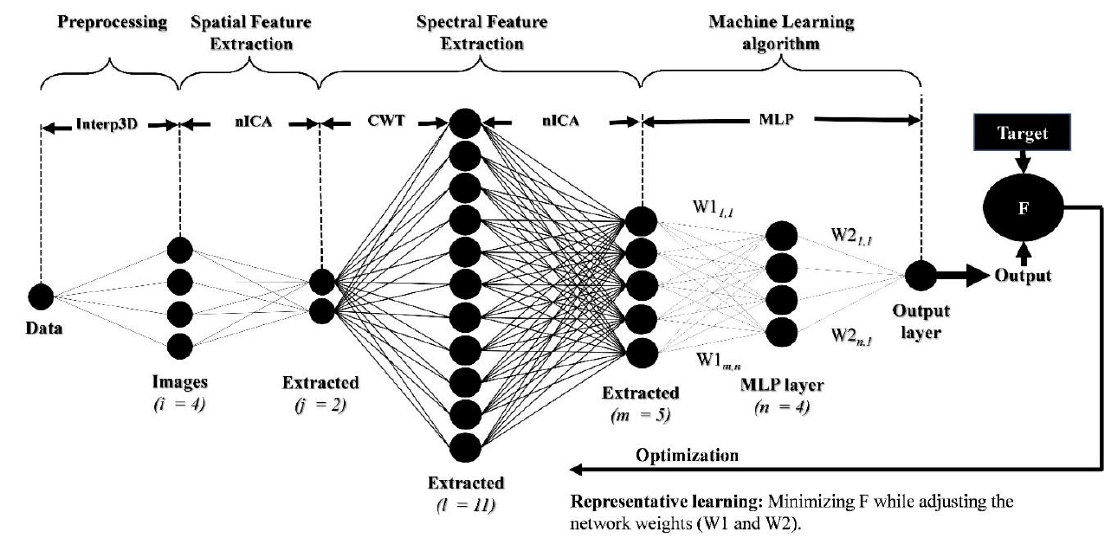
Figure 3. Schematic view of SRL for predictive modeling. The algorithm consists of four sub-modules: The preprocessing prepares the data sets by 3D inversion, interpolation, and filtering methods. The spatial feature extraction with nICA separates the image overlaps in 3D. Spectral feature extraction with CWT-nICA extracts the wavelet decomposed features. Furthermore, the machine learning algorithm with MLP adjusts network weights (W1 and W2) to learn patterns inside the extracted features based on the sample targets.